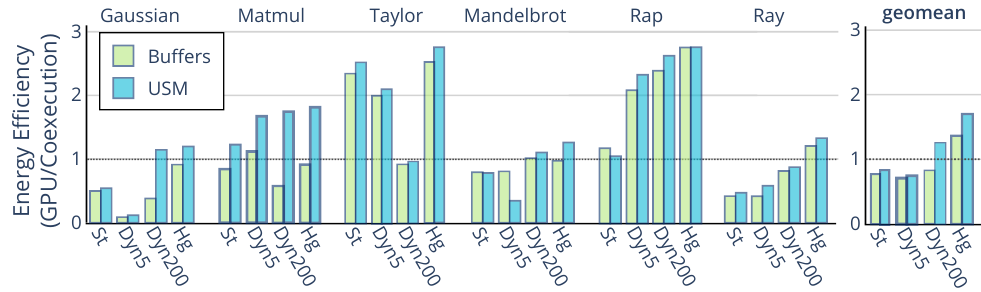
Figure 10. The energy efficiency compared with GPU (more is better) for the Desktop